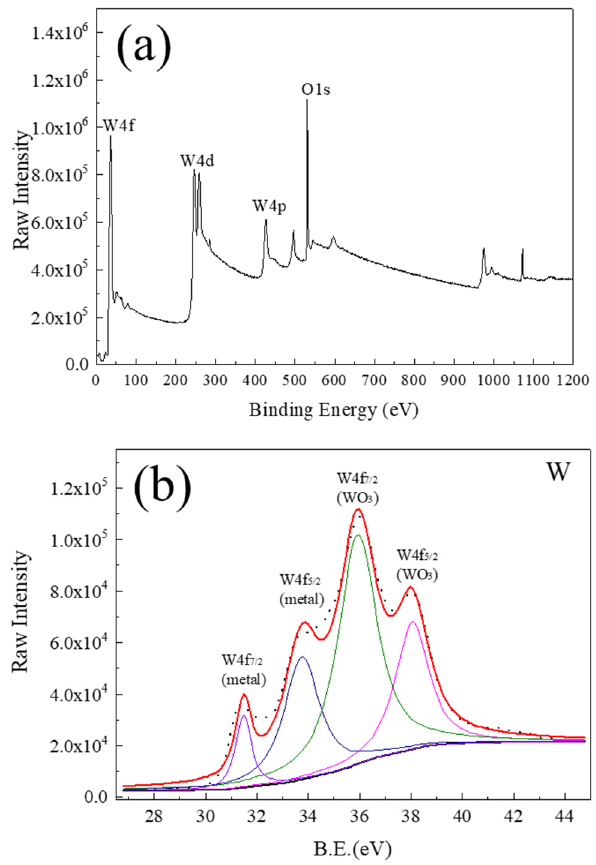
Figure 6. XPS analysis results of oxide film on pure tungsten specimen: ( a ) Survey spectrum and ( b ) W4f core level spectrum.